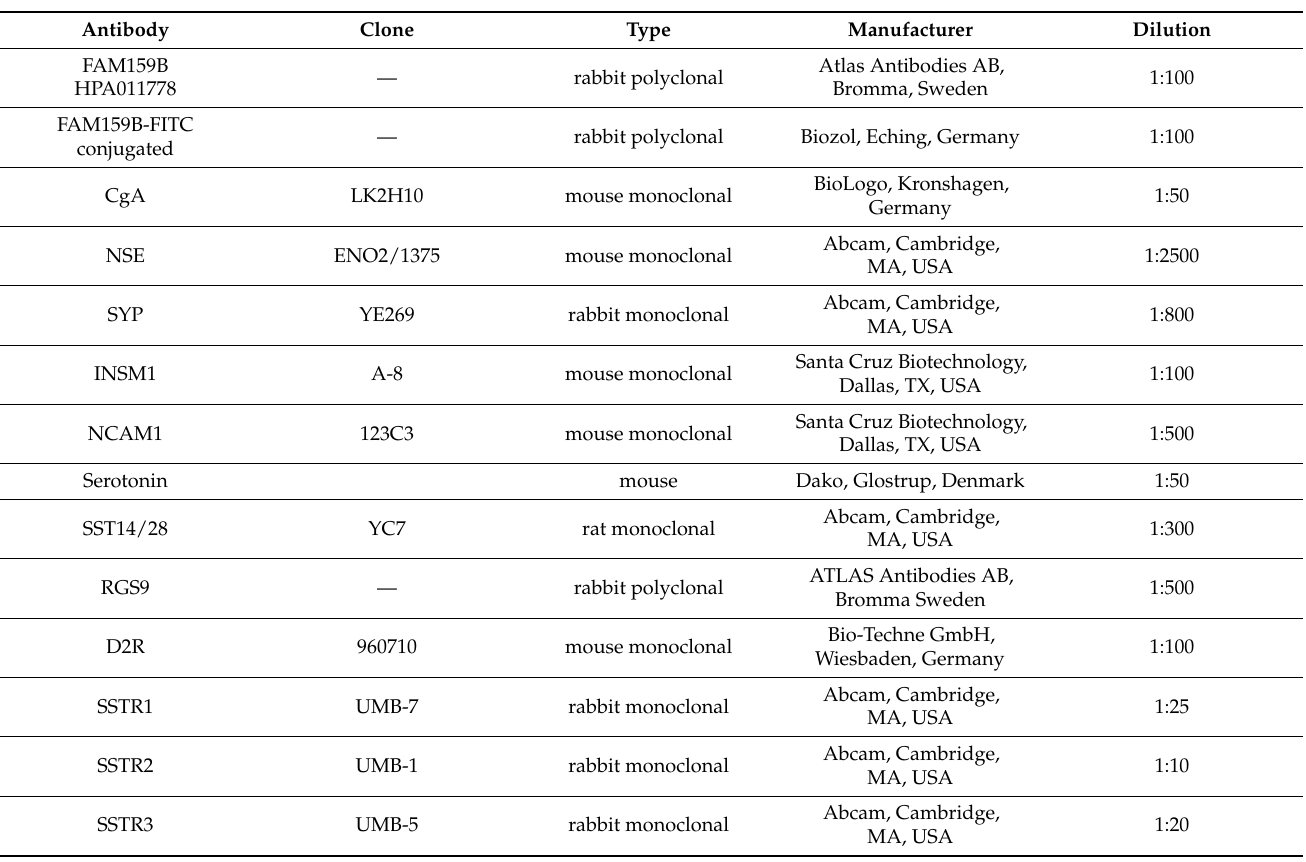
Table 1. Antibodies